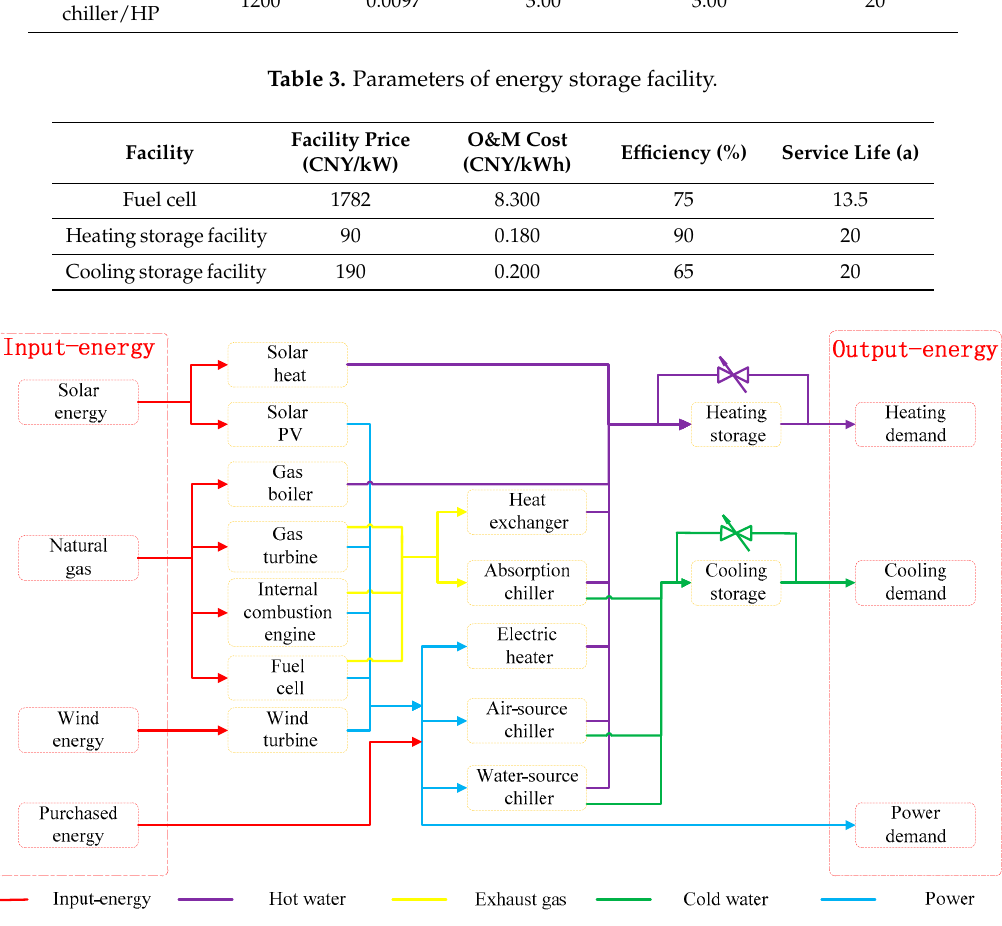
Figure 5. Operation principle of energy flow of each facility.